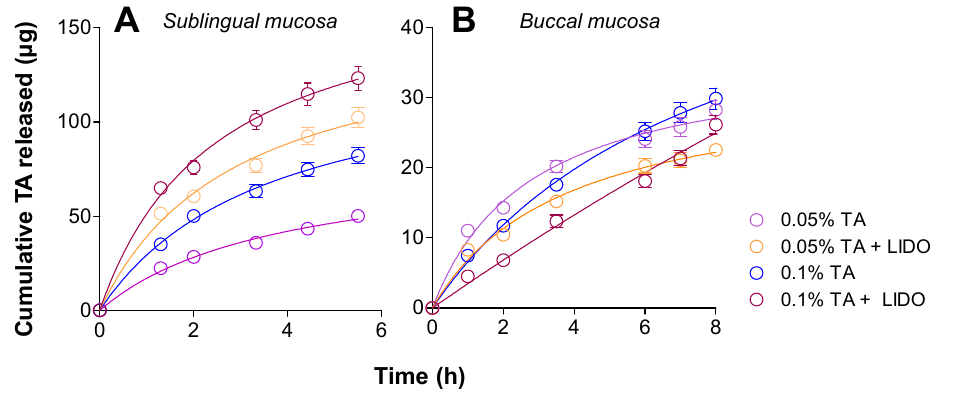
Figure 5. Cumulative amount of TA released ( µ g) to the phosphate buffered saline in dynamic conditions over time (h) when applied onto the ( A ) sublingual or ( B ) buccal mucosa. Values represent Mean ± SD ( n = 5).